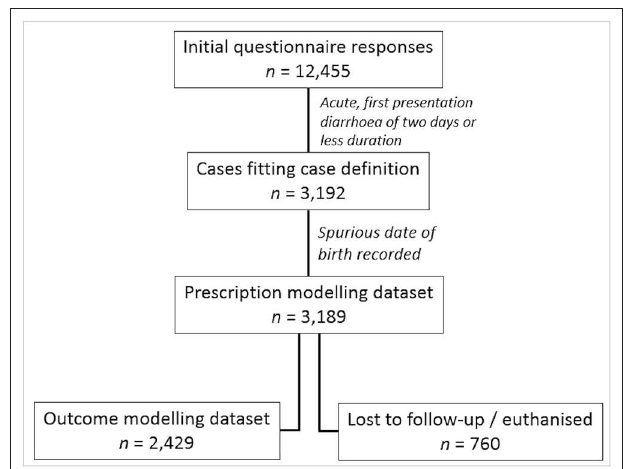
FIGURE 1 | Flow diagram showing case selection procedure for prescription modelling, loss to follow-up, and outcome